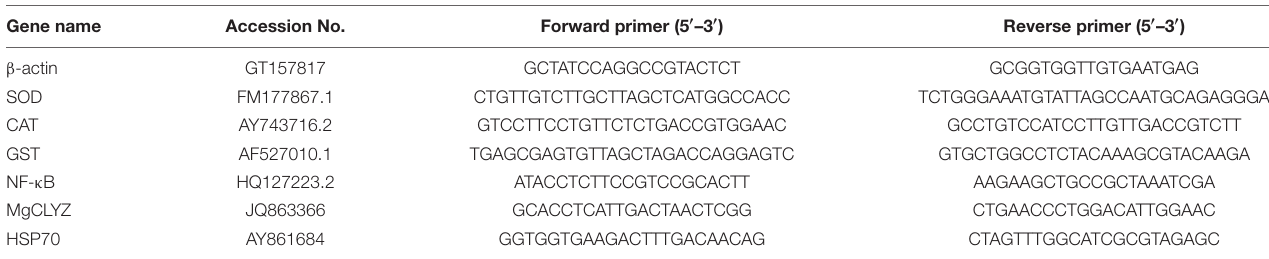
TABLE 1 | Primers used to determine internal control and quantify gene expression in